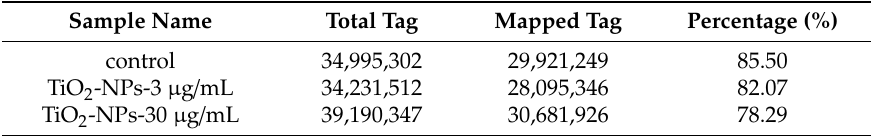
Table 3. Alignment statistics of tags align to reference Table 3 . Alignment statistics of tags align to reference genome .